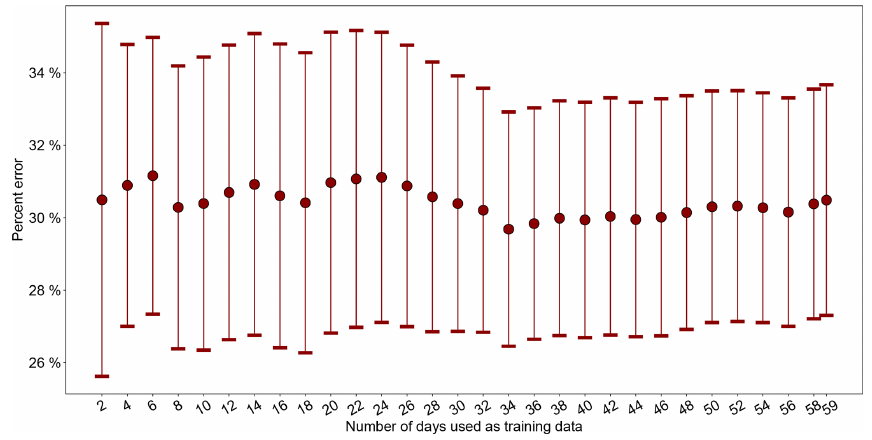
Figure 8. The mean percent error rate of GPR model prediction on the 22 reference nodes using leave-one-out CV (see Sect. 3.2.1) as a function of training window size in an increment of 2d. The error bars represent the standard error of the mean (SEM) of the GPR prediction errors of the 22 reference